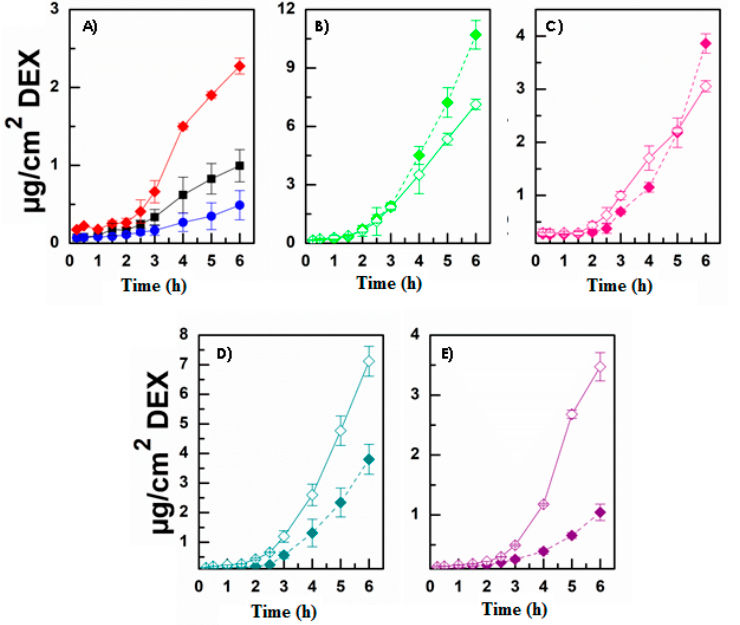
Figure 6. Ex vivo permeation studies: µ g/cm 2 of DEX permeated as a function of incubation time after administration of enhancer-functionalized micelles (solid symbols) or co-administration of INU-EDA-RA micelles with the enhancer solutions (open symbols). ( A ) INU-EDA-RA/DEX (red), DEX solution (black), and DEX suspension (blue), ( B ) INU-EDA-RA-PEG/DEX and INU-EDA- RA/DEX + PEG solution (green), ( C ) INU-EDA-TAU-RA/DEX and INU-EDA-RA/DEX + TAU solution (pink), ( D ) INU-EDA-RA-CAR/DEX and INU-EDA-RA/DEX + CAR solution (petrol green), ( E ) INU-EDA-RA-CRE/DEX and INU-EDA-RA/DEX + CRE solution (violet). Significance: p < 0.05.